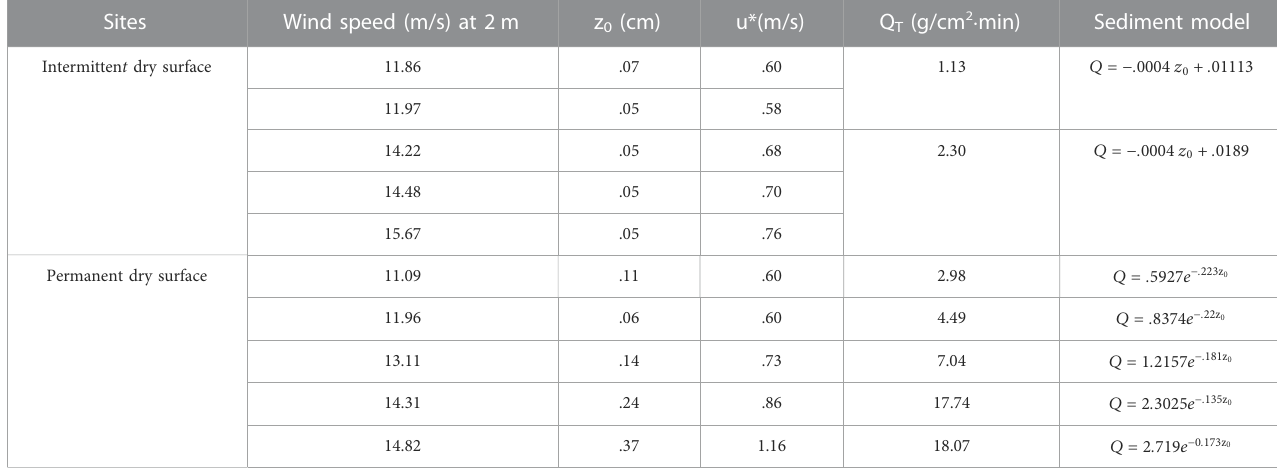
TABLE 2 Aerodynamic roughness length (z 0 , cm), calculated shear velocity (u*, m/s), and total transport rate (Q T ) at the two fi eld measurement sites. Sites Wind speed (m/s) at 2 m z 0 (cm) u*(m/s) Q T (g/cm 2 · min) Sediment model Intermitten t dry surface